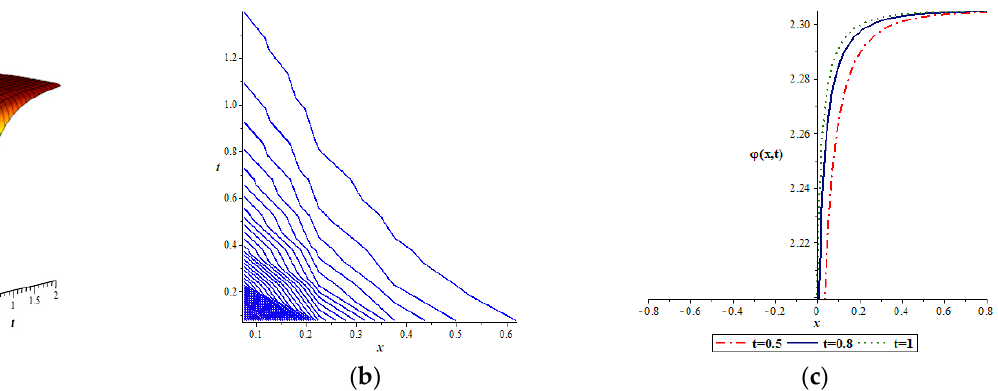
ϕ of Equation (54) for values = t , and 1,8.0,5.0 for 2D graph.